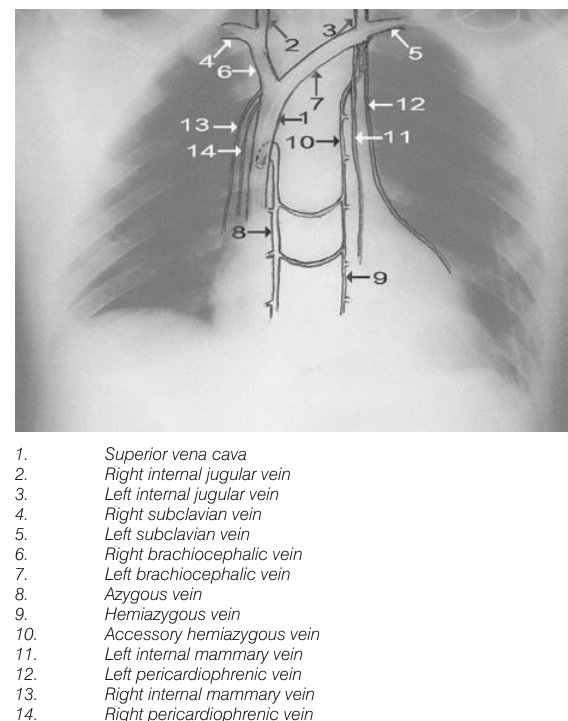
Figure 2. Posteroanterior radiograph of the same patient after left subclavian vein cannulation and incorporated diagram of thoracic veins (with only inferior tributaries of the brachiocephalic